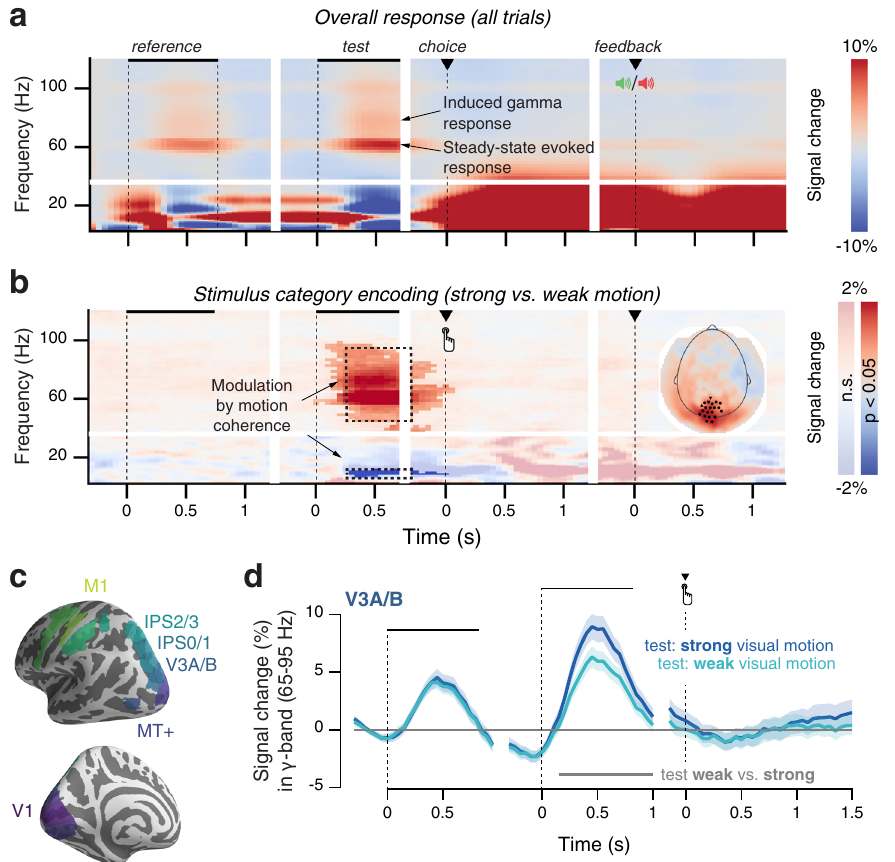
Fig. 2 | Task-related MEG dynamics in visual cortex. Time – frequency repre- sentationofMEGpowermodulationsrelativetopre-trialbaseline a acrosstrials,or b contrasting task-relevant stimulus categories (strong vs weak motion). Inset: occipital sensors, selected based on the visual motion-dependent gamma-band response. Shading indicates signi fi cant clusters in time-frequency space, as